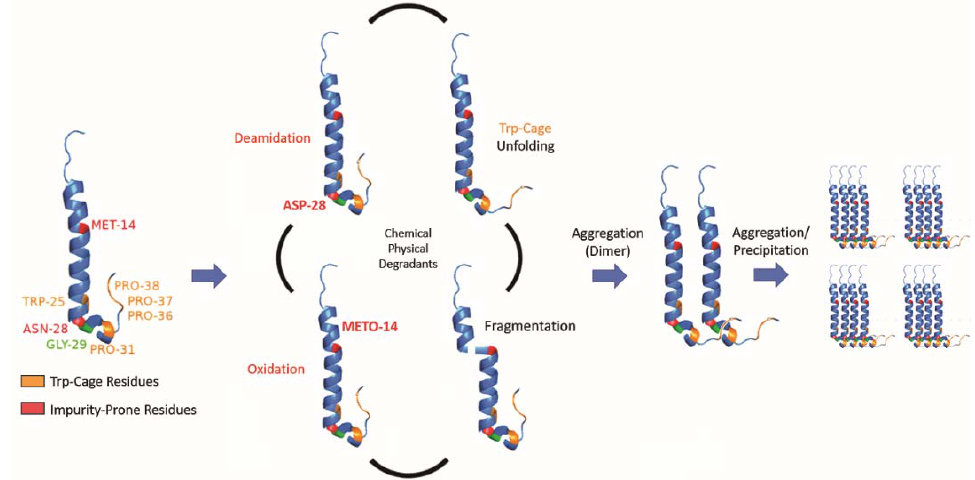
Figure 7. Schematic of proposed exenatide degradation, proceeding through a combination of chemical and physical degradations that includes N28 deamidation (at high pH), M14 oxidation, Trp-cage unfolding, and fragmentation. Degradation is followed by aggregation (dimerization), oligomer formation, and precipitation.